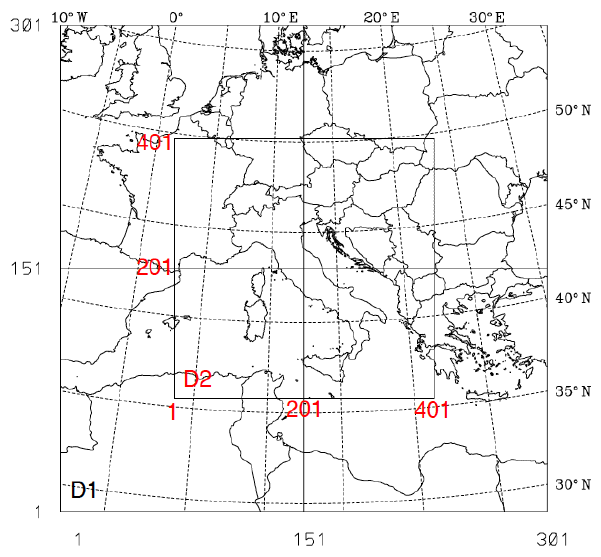
Figure 1. The two domains (D1, D2). D1 has 301 grid points in both the WE and SN directions; D2 has 401 grid points in both WE and SN